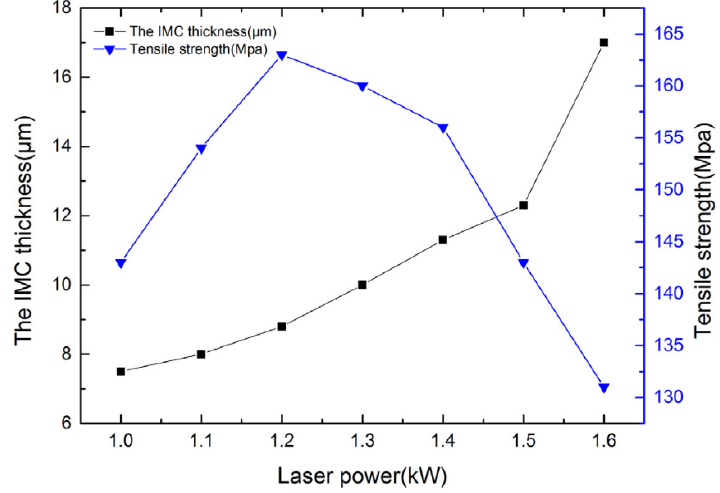
Figure 9. Effect of laser power on IMC thickness and tensile strength. Reprinted with kind permission of Elsevier 2017 from Reference [31].